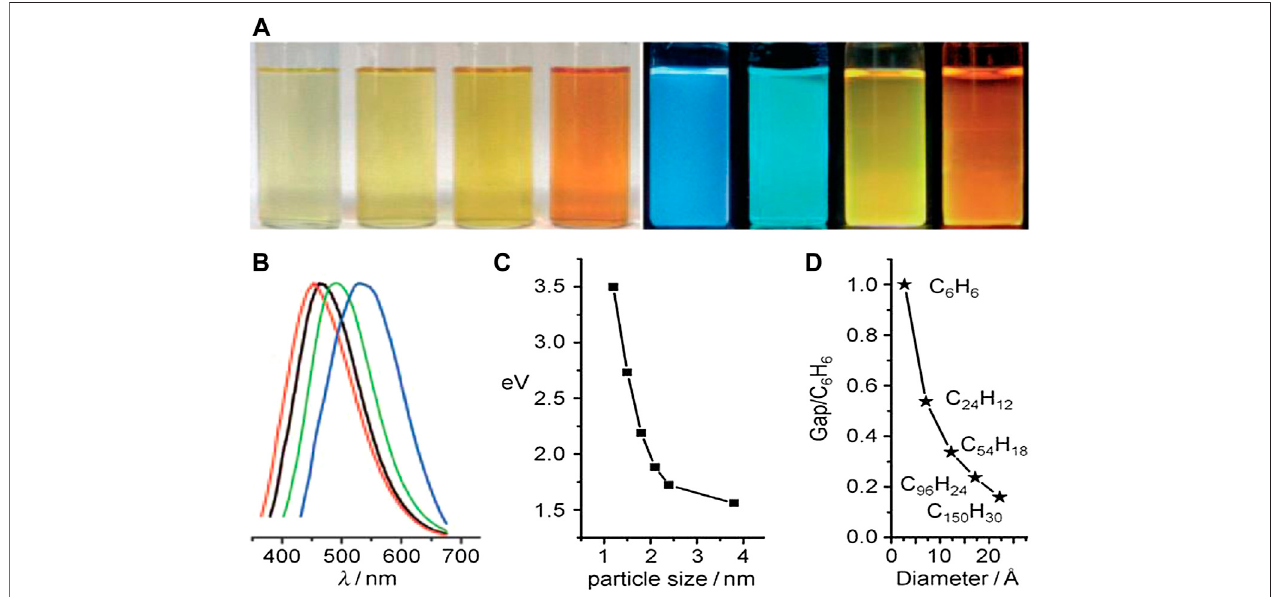
FIGURE 11 | Size effect of CQDs. (A) Typical sized CQDs optical images illuminated under white (left; daylight lamp) and UV light (right; 365 nm); (B) PL spectra of typical sizedCQDs:thered,black, green, andbluelines arethePLspectraforblue-, green-,yellow-, and red-emissionCQDs,respectively; (C) relationship betweenthe CQD size and the PL properties; and (D) HOMO – LUMO gap dependence on the size of the CQDs. Reprinted with permission from (Li et al., 2010).